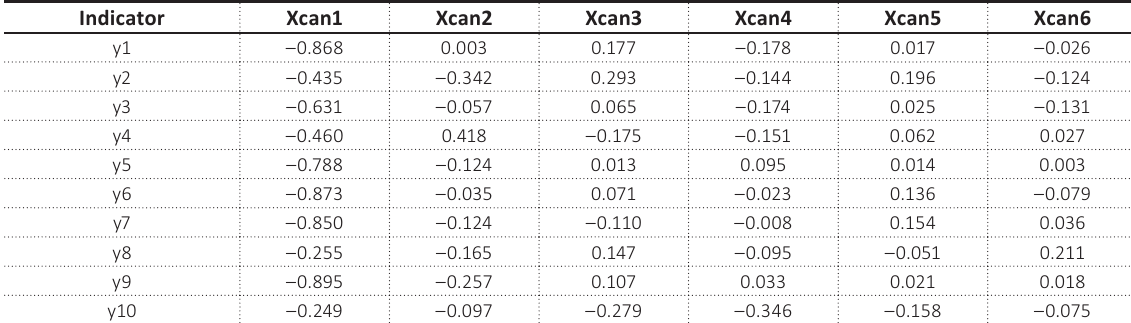
Table 9. Cross-loading of labor market efficiency indicators with higher education and training canonical variates (Xcan)